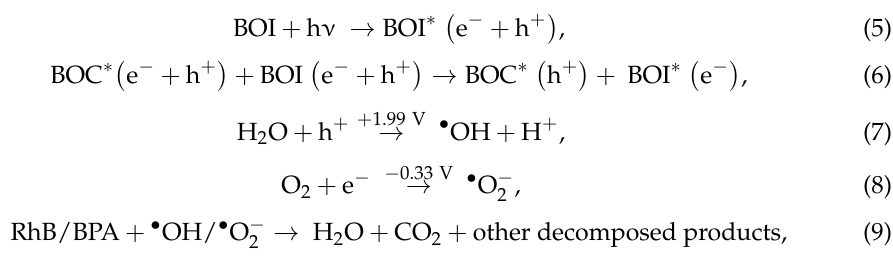
(b) BPA degradation; Table S1: Obtained parameters from the TRPL curves; Table S2: Comparison of photocatalytic degradation of RhB with recently reported literature; Table S3: Comparison of photocatalytic degradation of BPA with recently reported literature. References [15,16,26,37,56–84] are cited in the Supplementary